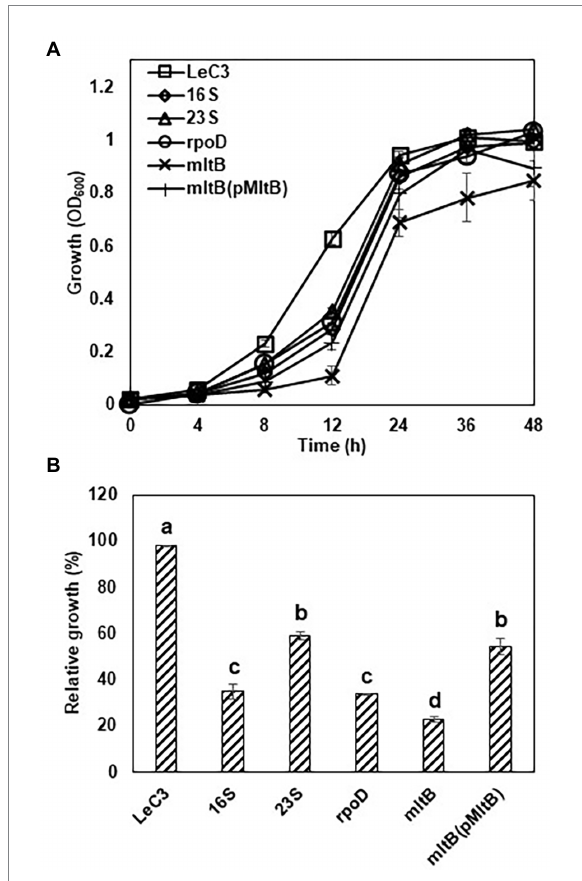
FIGURE 2 Selected mutants exhibited decreased spectinomycin resistance and slower growth. (A) Growth curve of Lysobacter enzymogenes strain C3 (LeC3) and its derived strains. Bacterial growth was monitored at different time points by measuring OD 600 . Data points represented the means of three replicates ± SD. (B) Spectinomycin resistance of LeC3 and its derived strains. Spectinomycin resistance was calculated as the ratio of bacterial growth with 400 μ g/ml spectinomycin to bacterial growth without spectinomycin at 22 h post-inoculation. Error bars represented SD. Different letters indicated significant differences from one-way ANOVA followed by Fisher’s LSD test ( p < 0.05). LeC3, Lysobacter enzymogenes strain C3; 16S , the 16S rRNA mutant; 23S , the 23S rRNA mutant; rpoD , the rpoD mutant; mltB , the mltB mutant; and LaATCC, L. antibioticus strain